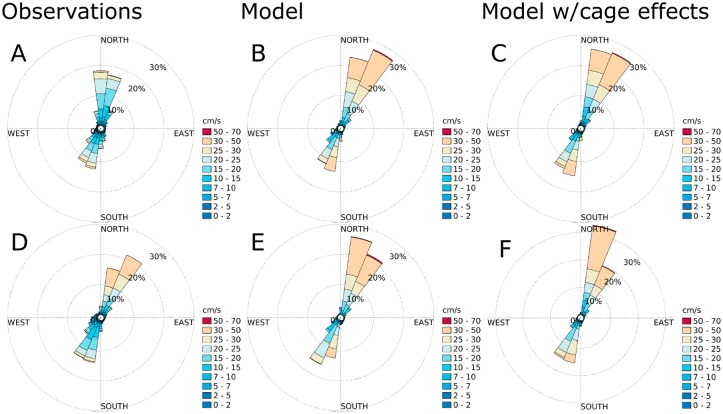
Current roses for ADCP2 (Fig 5) at 10 m depth.A: observations for August-October, 2015. B: simulation results without cage effects for August-October, 2015. C: simulation results with cage effects for August-October, 2015. D: observations for May-June, 2016. E: simulation results without cage effects for May-June, 2016. F: simulation results with cage effects for May-June, 2016. The colors indicate current speed. Each sector spans 15°.